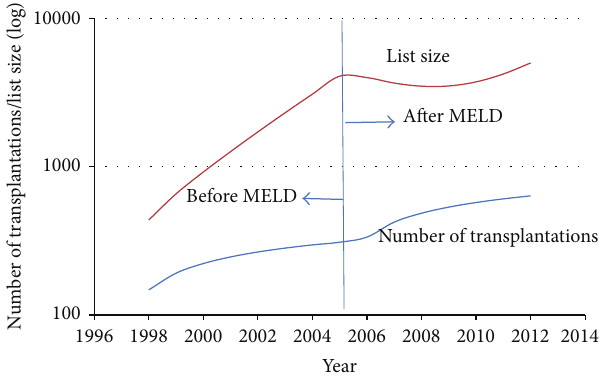
Figure 3: Fitting of (2) to the data from Tables 1 (before MELD) and 2 (after MELD).